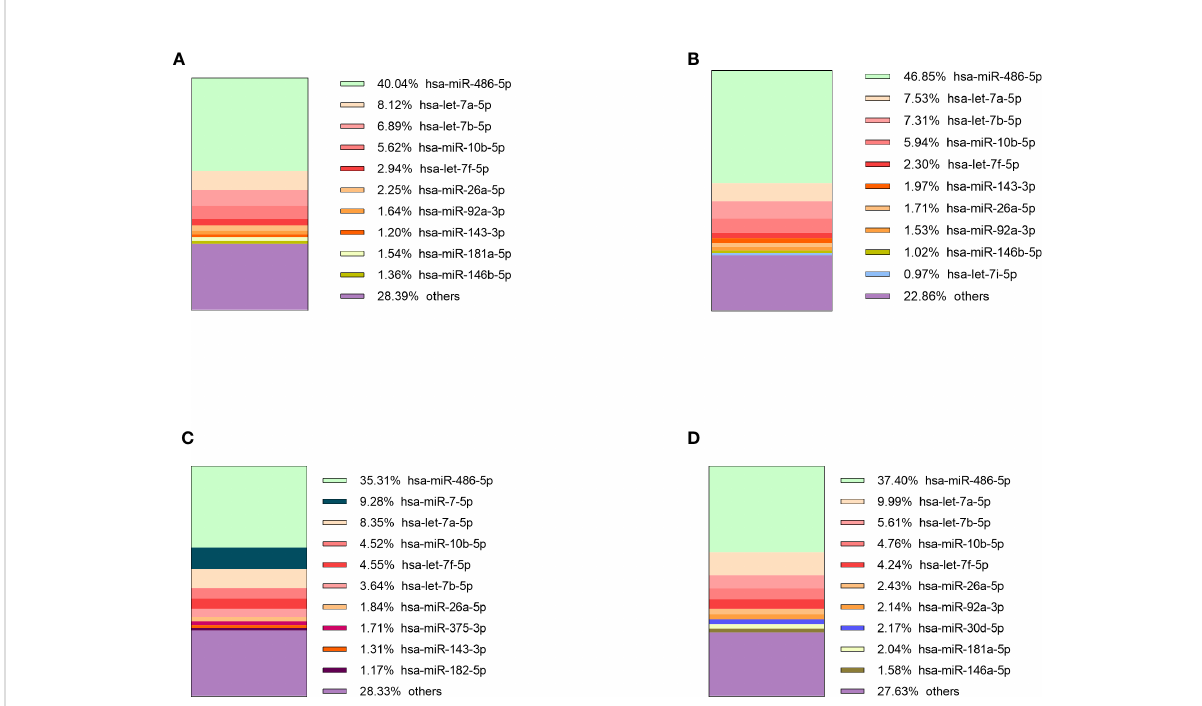
FIGURE 3 10 most expressed miRNAs in plasma of: (A) NF PitNET patients, (B) GH secreting PitNET patients, (C) PRL secreting PitNET patients, (D) ACTH secreting PitNET